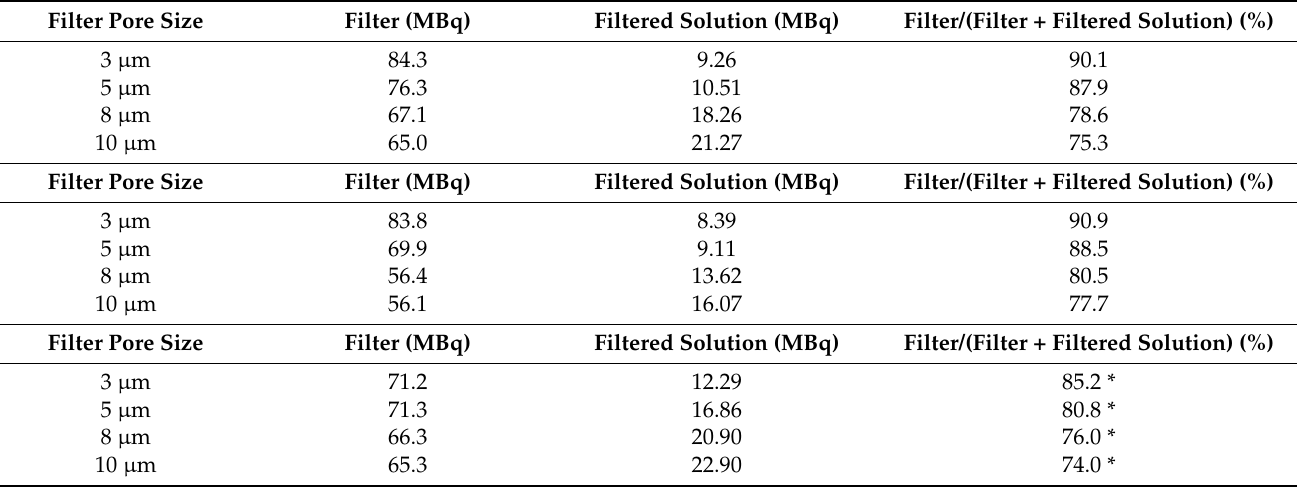
Table 2. Table showing filter test results from three examinations of the problem encumbered [ 99m Tc]Tc-Makro-Albumon